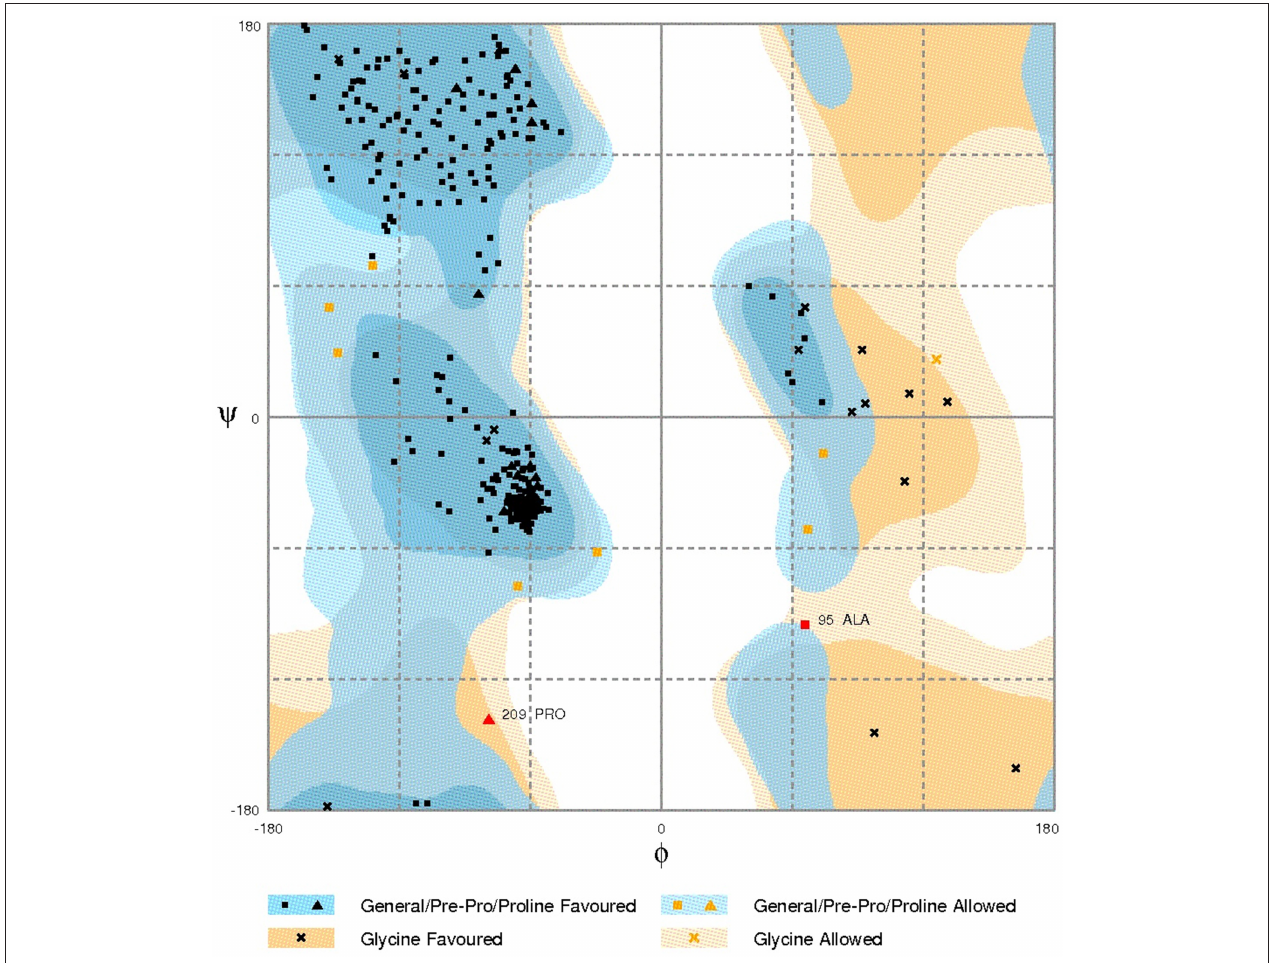
FIGURE 3 | Ramachandran plot analysis of Cry1Ac-Vip3Aa fusion protein model to visualize dihedral angles; ϕ against ψ . At the bottom of the image the summary of evaluating residues is presented.